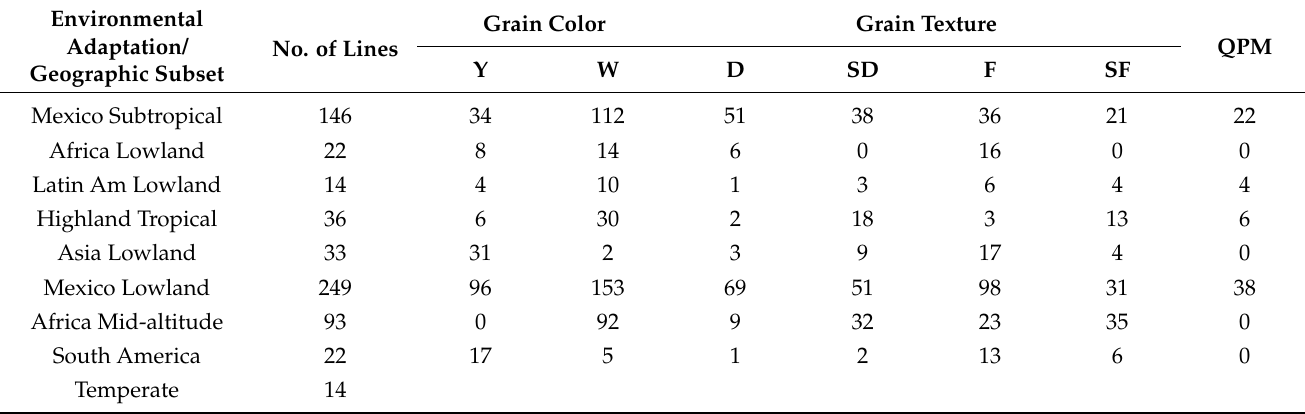
Table 3. Environmental adaptation, geographic subset, and phenotypic characterization information of 615 CMLs and 14 temperate maize inbred